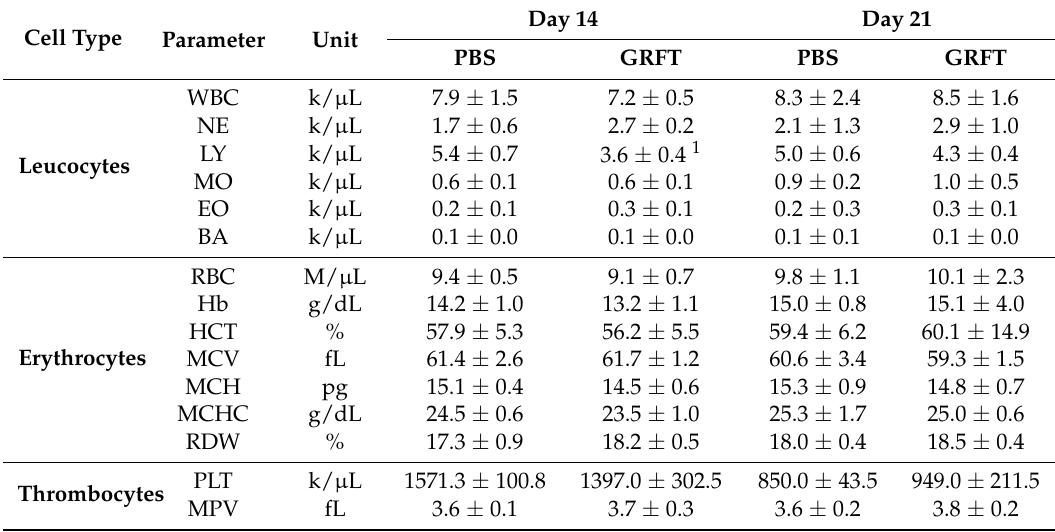
Table 2. Effect of 14 daily s.c. doses of 10 mg/kg GRFT on a mouse hematological